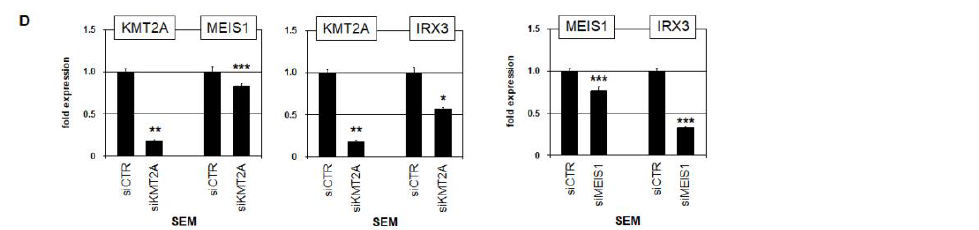
Figure 6. MEIS1 activates IRX3. ( A ) Expression profiling data for MEIS1 and HOXA10 from BCP-ALL patients using dataset GSE79533. Subtypes showing significant expression levels are indicated by a blue line. ( B ) Expression profiling data for MEIS1 and HOXA10 from hematopoietic progenitor cells including CMP, MEP, pro-B-cells and pre-B-cells using dataset GSE19599. ( C ) RQ-PCR analysis of HOXA10 in BCP-ALL cell lines. Subtypes of BCP-ALL are indicated. ( D ) RQ-PCR analysis of SEM cells treated for siRNA-mediated knockdown of KMT2A (left, middle) and MEIS1 (right). p -values are indicated by asterisks (* p < 0.05, ** p < 0.01, *** p < 0.001, n.s. not significant).